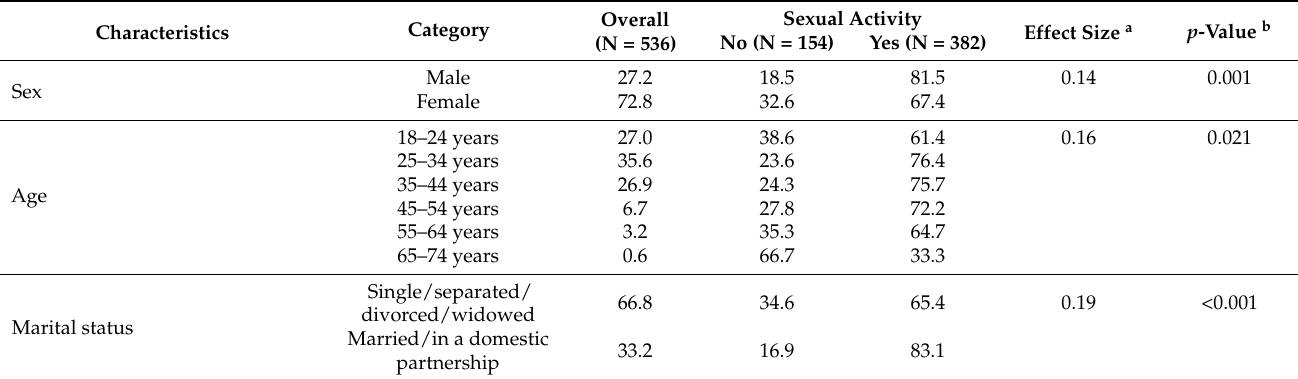
Table 1. Sample characteristics (overall and by sexual activity